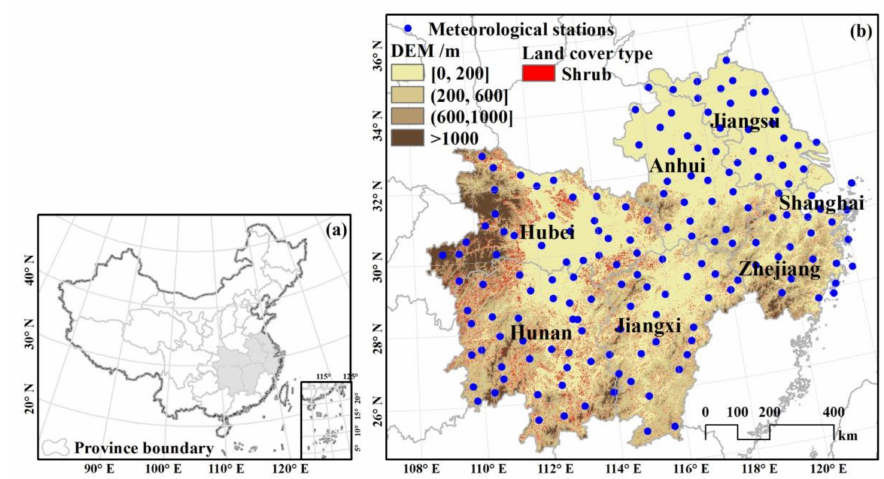
Figure 1. Study area ( a ) and its meteorological stations shown as blue circles ( b ) in the middle and lower reaches of the Yangtze River region, China. In panel ( b ), the elevation in four levels was mapped with different shades of yellow, and the land cover type of shrub was denoted with red